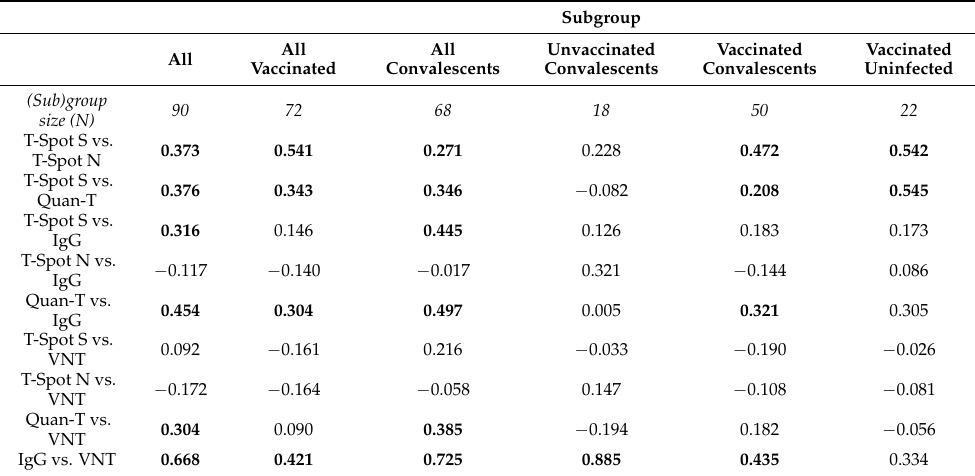
Table 2. Correlations (Spearman correlation coefficients) between individual tests of humoral and cellular immunity. Statistically significant correlations are highlighted in bold.